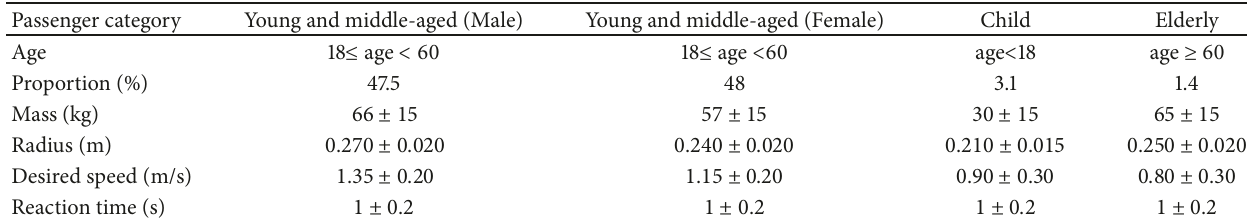
Figure 8: The simplified 2D diagram of the platform of line 4 at Xuanwumen subway station. Table 2: Passengers’ basic attributes at the platform of line 4 of Xuanwumen subway